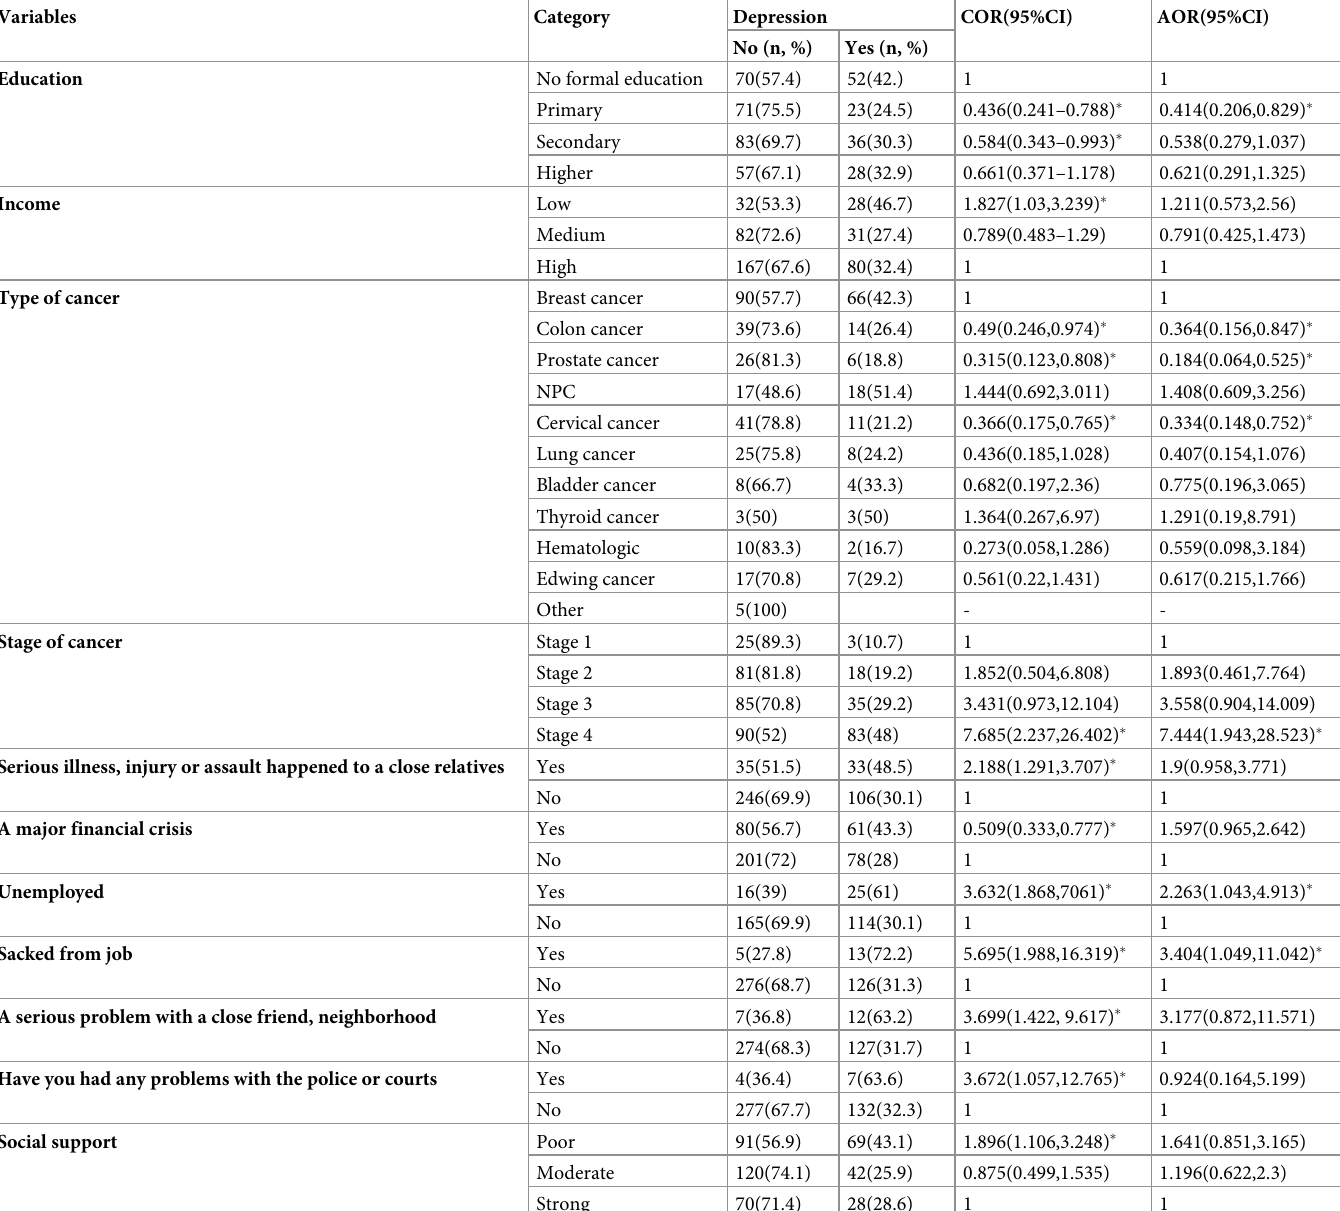
Table 4. Bivariate and multivariate logistic regression analysis of independent factors to depression among cancer patients at the oncology clinic of TASH, Addis Ababa, Ethiopia, 2021.